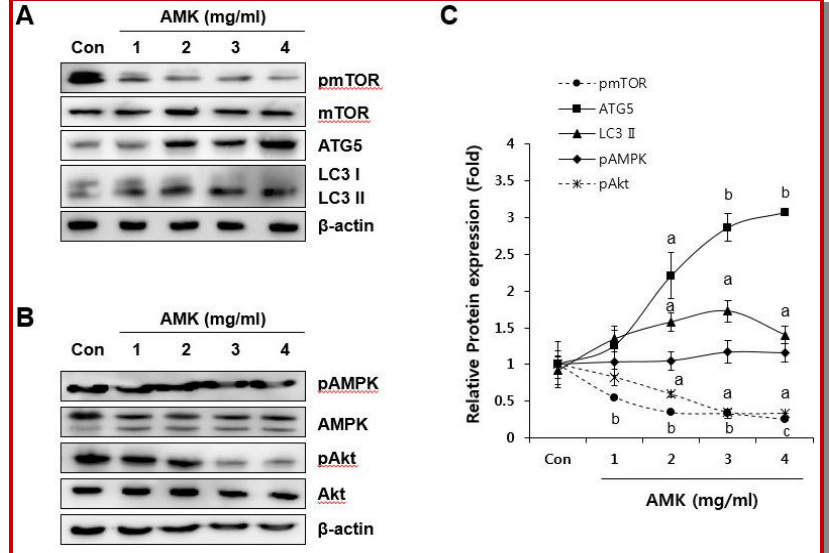
Figure 4: A. macrocephala (AMK)-induced autophage via inhibition of Akt/mTOR pathway. (A) After incubation with A. macro- cephala for 24 hours in a dose-dependent manner, cells lysates were prepared, then subjected to Western blot to measure pmTOR, mTOR, ATG5, and LC3. Data represent 2 independent experiments. (B) Cell were treated as above. Western blot performed to measure the expression levels of pAMPK, AMPK, pAkt, and Akt. Equal protein loading was confirmed by the antibody reaction to β - actin. (C) Summary of effects of A. macrocephala on the expression of autophage related proteins. Protein levels were measured by densitometry and their relative levels were compared with the non-treated control. a p<0.01, b p<0.001, and c p<0.0001 vs. non- treated